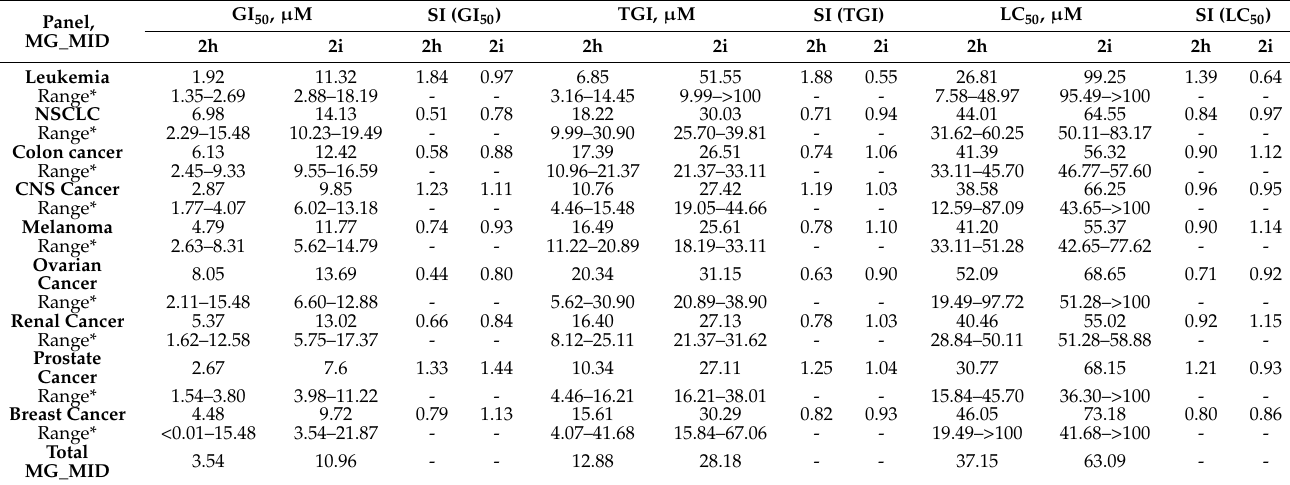
Table 3. Influence of compounds 2h and 2i on the growth of tumor panels (GI 50 , TGI, LC 50 ) and selectivity index (SI) values. Panel, MG_MID